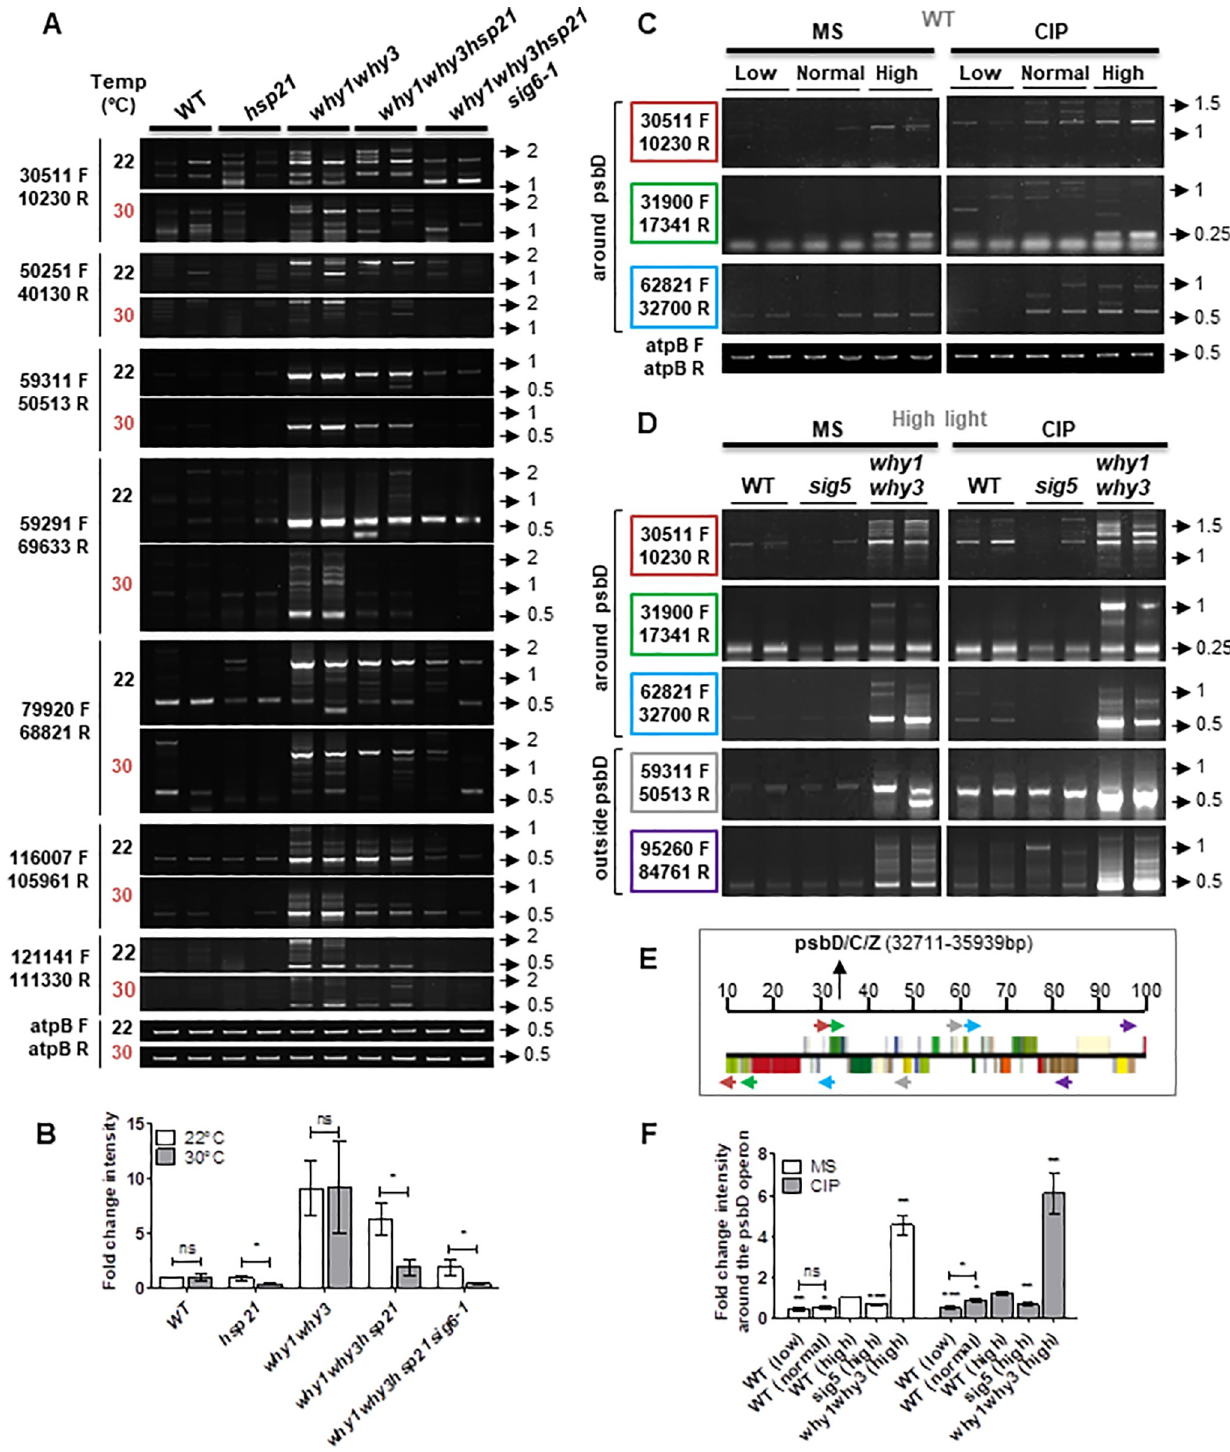
Fig 2. Modulation of PEP-dependent transcription affects plastid genome stability. (A) PCR analysis of ptDNA rearrangements in wild type (WT), hsp21 , why1why3 , why1why3hsp21 and why1why3hsp21sig6-1 plants grown in solid basal media at normal (22˚C) or high temperature (30˚C). (B) The bar graph represents the fold change intensity (mean ± standard error) of the PCR bands in A compared to WT for each primer pair (n = 8). (C, D) PCR analysis of ptDNA rearrangements in the proximity of the psbD locus in (C) wild-type (WT) plants grown in low, normal, or high light conditions (10, 100 or 1,000 μ mol photons m–2 s–1) and (D) WT, sig5 and why1why3 plants grown in high light conditions, for 14 days on solid basal media alone (MS) or